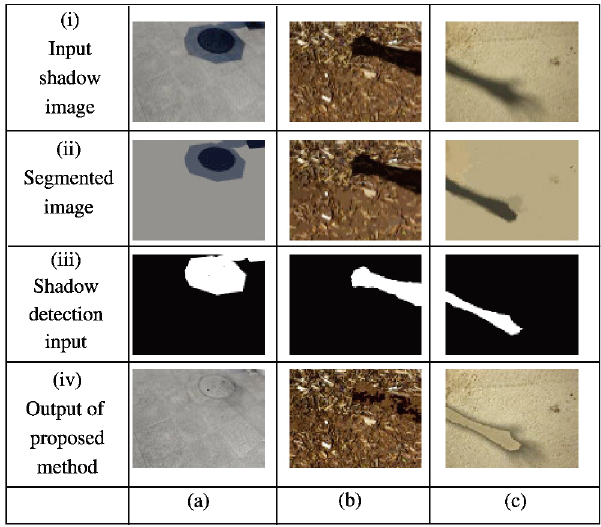
Fig. 8 Failures of the proposed shadow removal method for (a) object completely in shadow, (b) shadow on a complex textured surface, and (c) soft shadow with highly diffuse